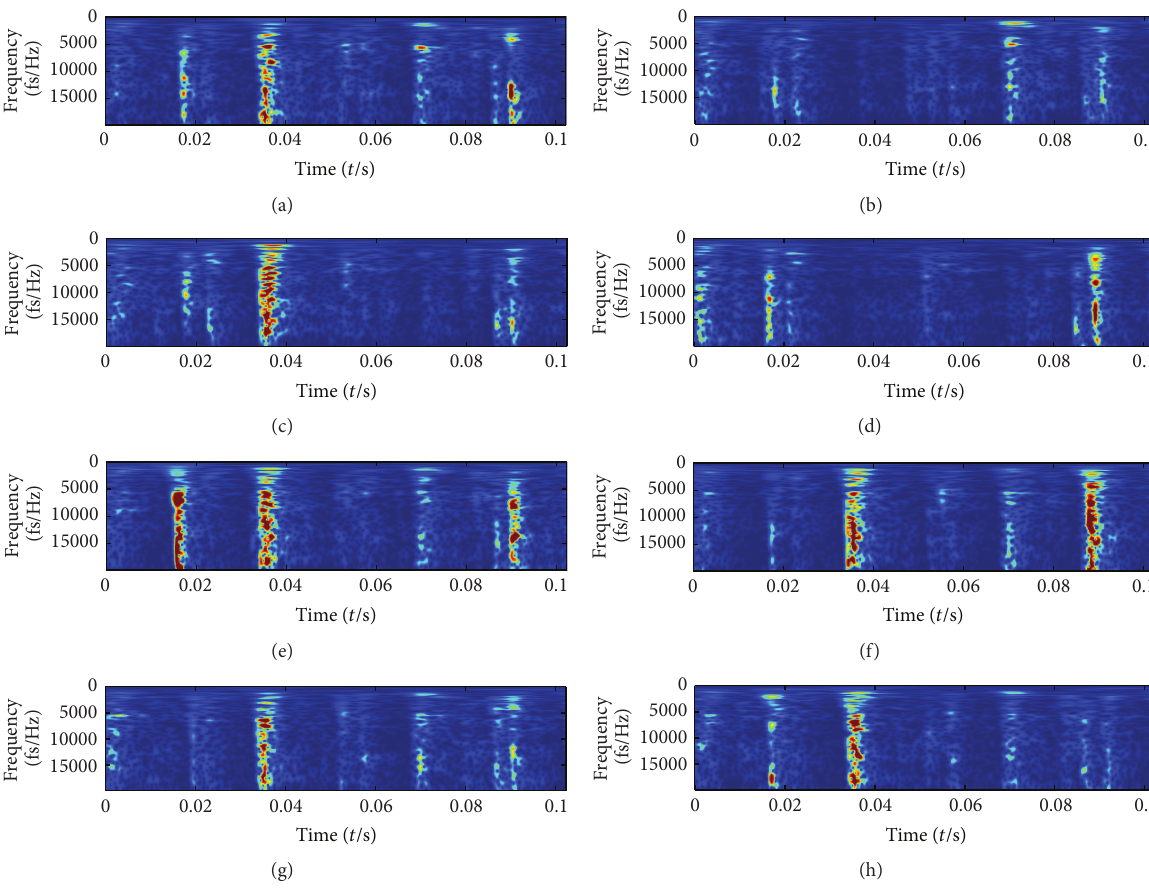
Figure 5: The 𝑆 transform of the eight engine states: (a) normal state; (b) first cylinder misfire; (c) second cylinder misfire; (d) first and second cylinder misfire; (e) too large clearance of intake valve; (f) too large clearance of exhaust valve; (g) air leakage of the intake valve; (h) air leakage of the exhaust valve.